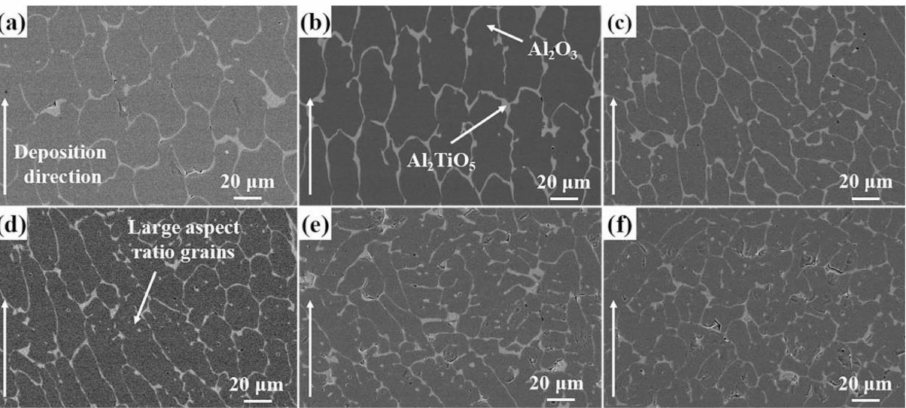
Figure 4. Microstructure of alumina + aluminum titanate composite ceramics for a scanning speed of 50 ( a ), 100 ( b ), 300 ( c ), 500 ( d ), 700 ( e ), and 900 ( f ) mm/min [54]; with permission from